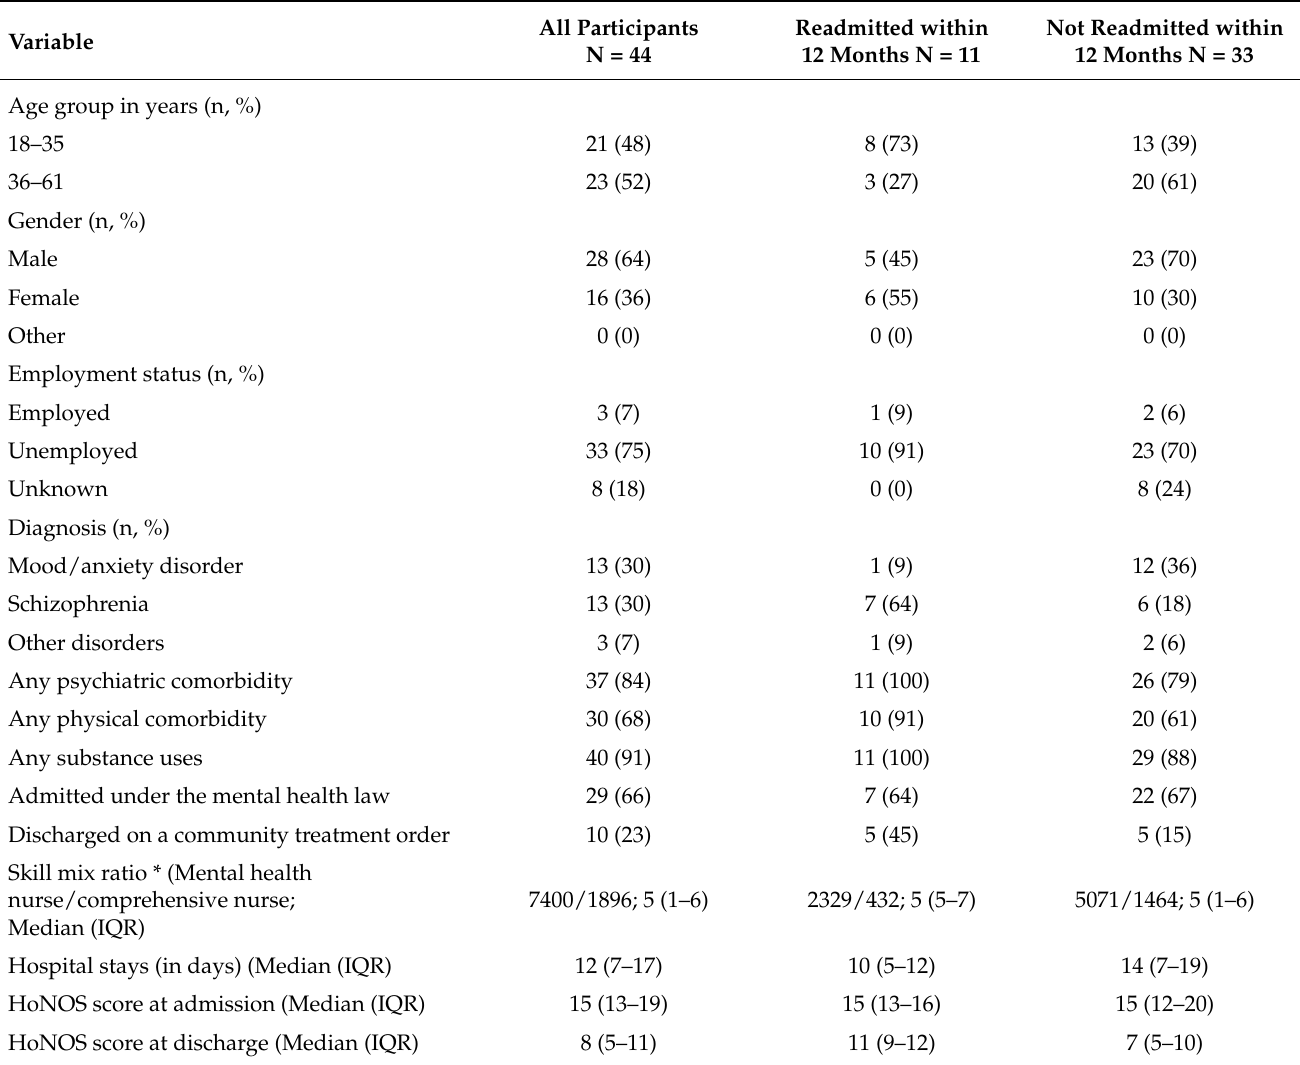
Table 2. Demographic and clinical characteristics of